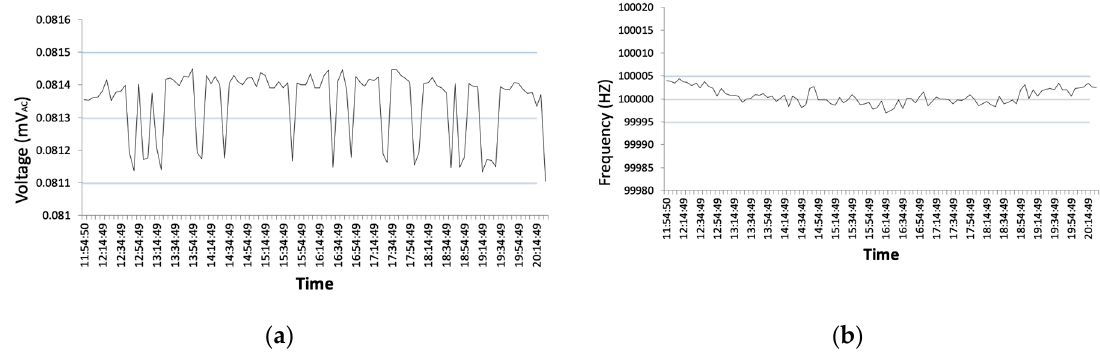
Figure 8. Test conducted over 8 h using HP 34970A: ( a ) AC voltage deviation; and ( b ) frequency